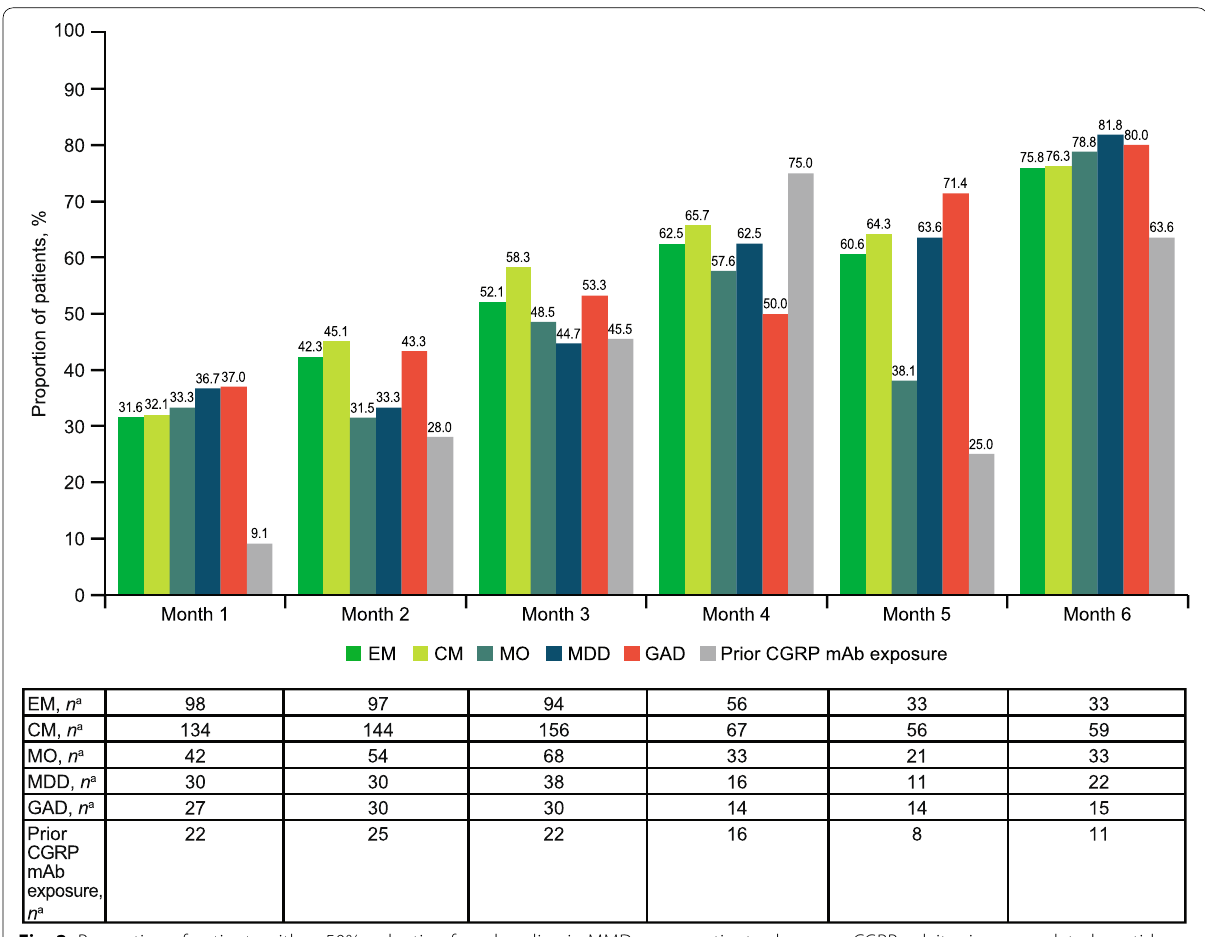
Fig. 2 Proportion of patients with 50% reduction from baseline in MMD across patient subgroups. CGRP, calcitonin gene‑related peptide; ≥ CM, chronic migraine; EM, episodic migraine; GAD, generalized anxiety disorder; mAb, monoclonal antibody; MDD, major depressive disorder; MMD, monthly migraine days; MO, medication overuse. a Number of patients with available assessment at each time